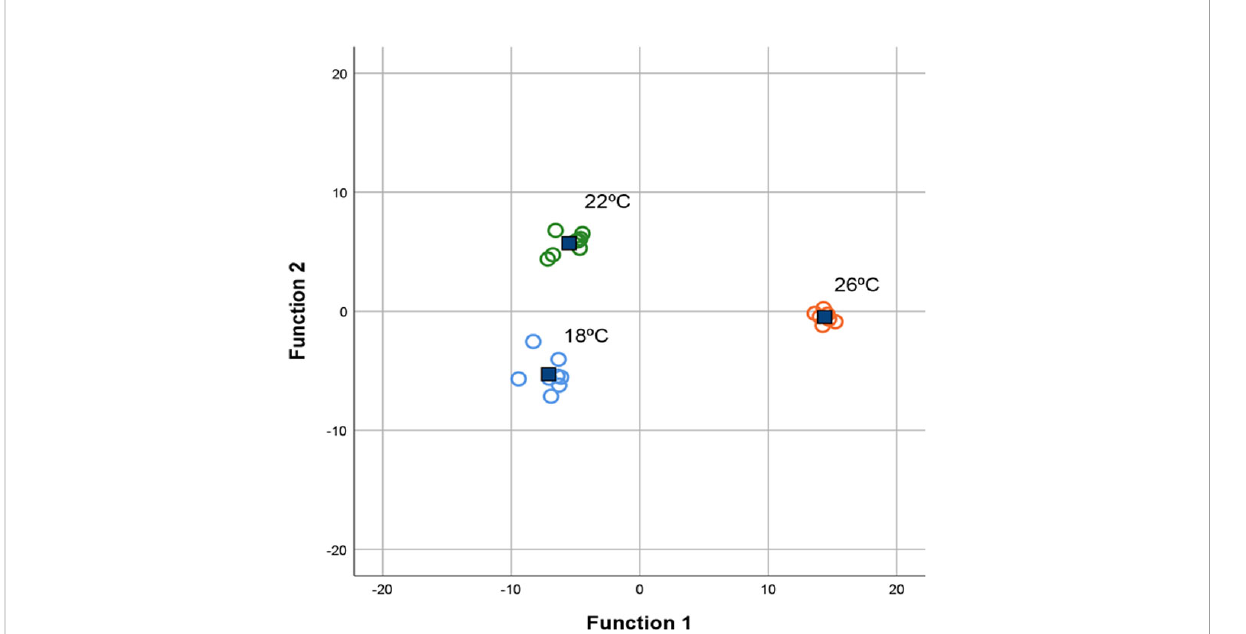
FIGURE 3 Plot of the two axes from the forward stepwise discriminant function analysis of digestive enzymes total activities in Seriola dumerili juveniles reared at 18 (blue), 22 (green) and 26°C (orange). Group centroids are represented by blue